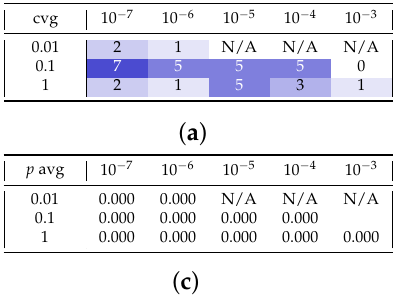
Figure A8. The test set G provides a sensitivity analysis on the number of shots s , with SPSA in the generator. ( a ) Converging runs, out of 10. ( b ) Number of epochs before convergence, on average. ( c ) p -value for the χ 2 test once convergence is reached (average over converging runs). ( d ) p -value for the χ 2 test once convergence is reached (best run). ( e ) Visual representation of the epochs before convergence. ( f ) Visual representation of the p -value.